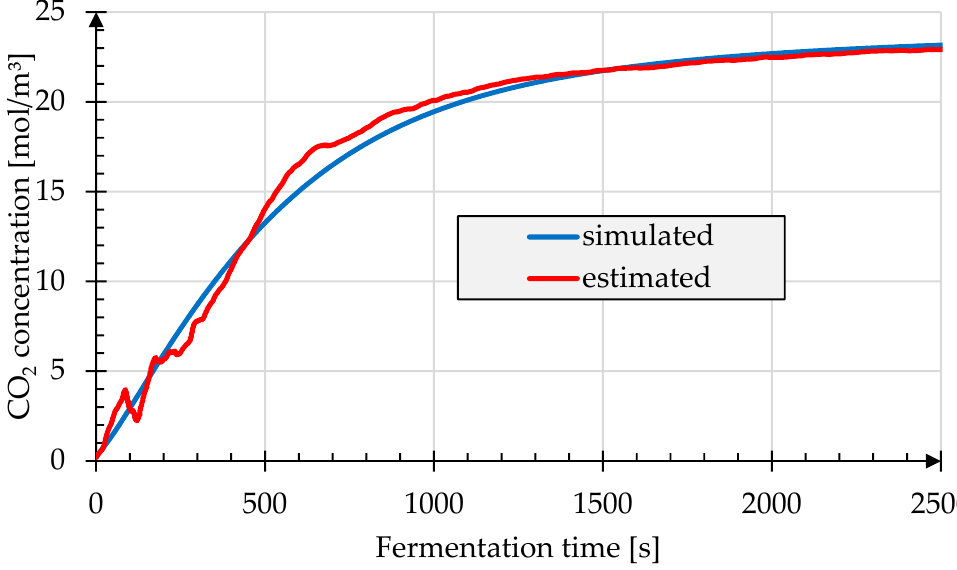
Figure 3. Simulated and Kalman estimation of the CO 2 concentration in non-gaseous